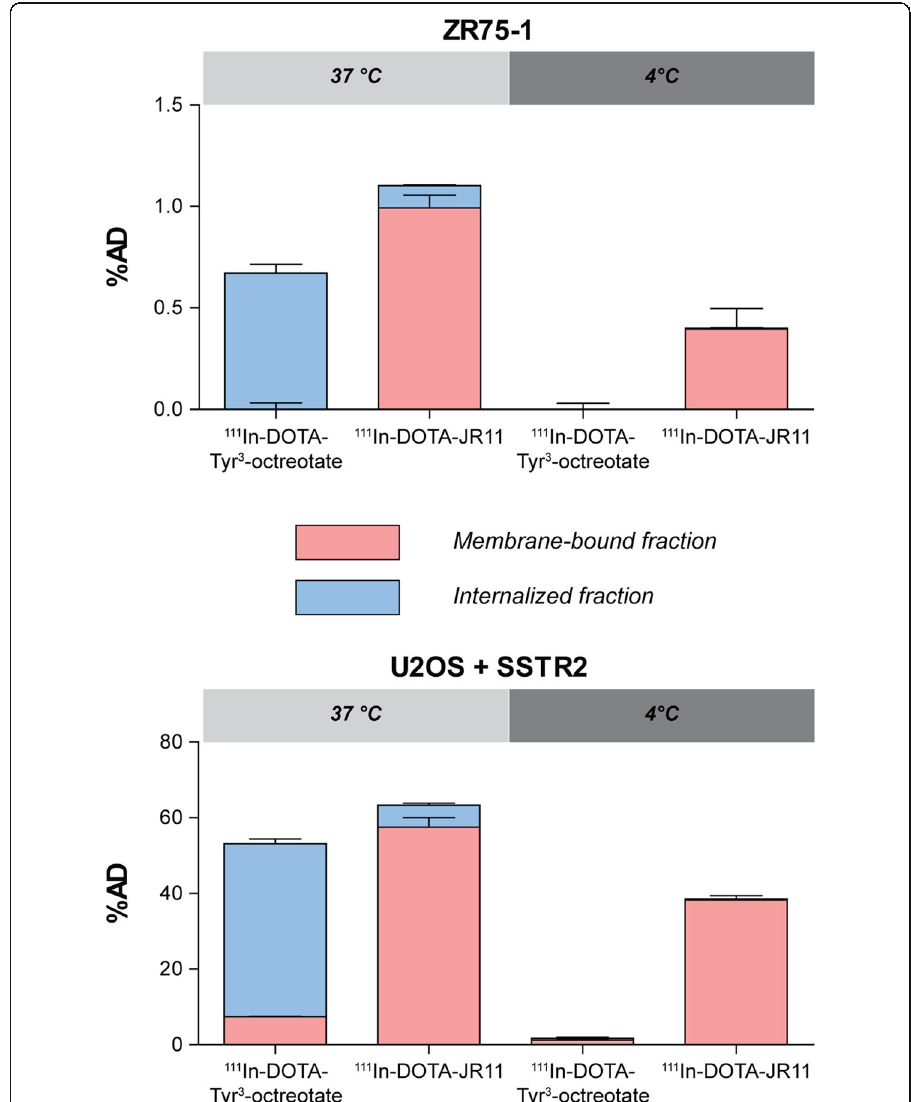
Fig. 1 Binding and internalization of 111 In-DOTA-Tyr 3 -octreotate and 111 In-DOTA-JR11 to the endougenously SSTR expressing cell line ZR75 – 1 and the SSTR2 transfected cell line U2OS + SSTR2. Cells were incubated for 1 h at 37 °C or 4 °C with 10 − 9 M of the agonist or the antagonist. The bars represent the percentage added dose (%AD) bound and/or internalized (in)to the cells. The %AD is corrected for unspecific binding